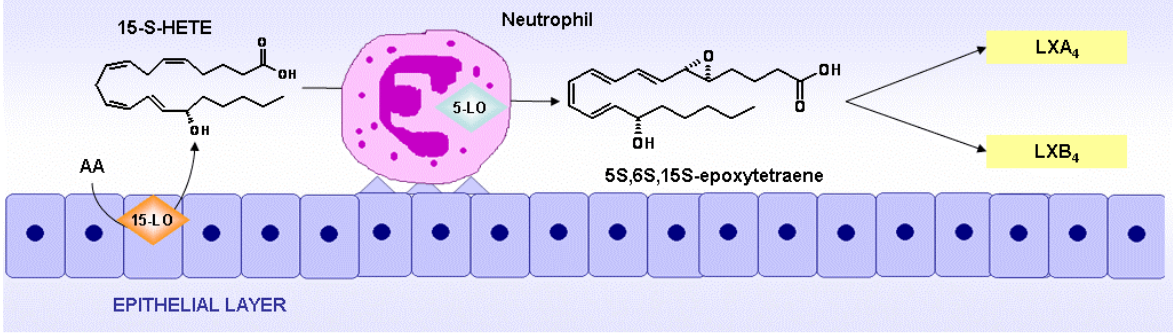
FIGURE 2 . The 5-/15-LO pathway of LX biosynthesis (see text for